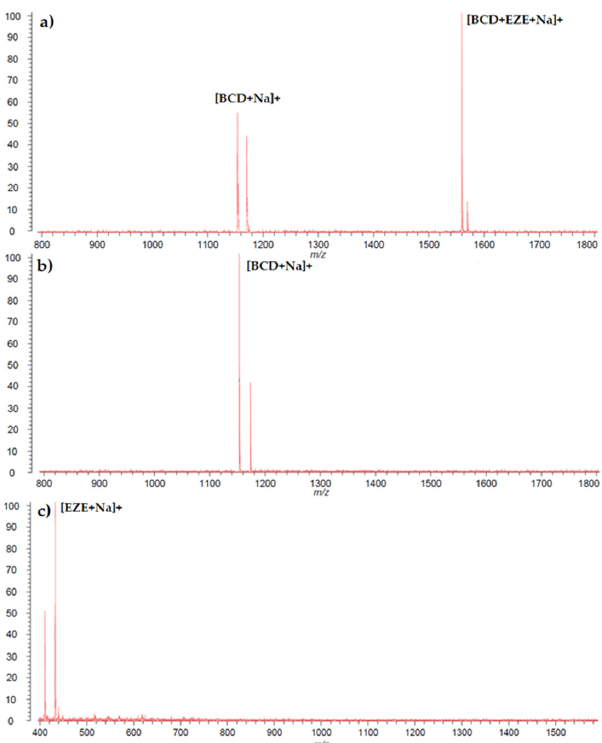
Figure 9. MALDI TOF mass spectrum of the ( a ) complex of ezetimibe and β -CD, ( b ) β -CD, and ( c )